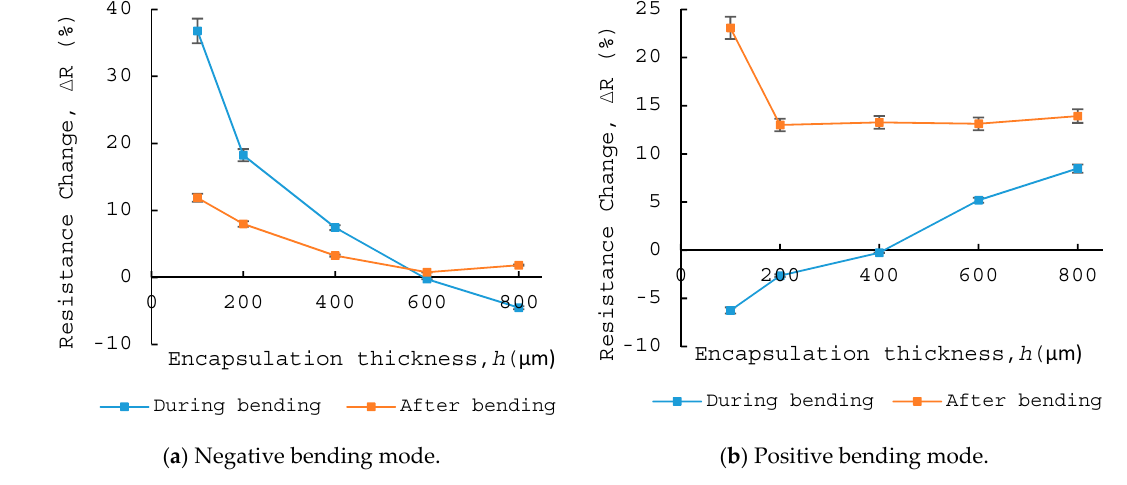
Figure 3. Resistance changes for gauges on Bari fabric along warp and weft weave.